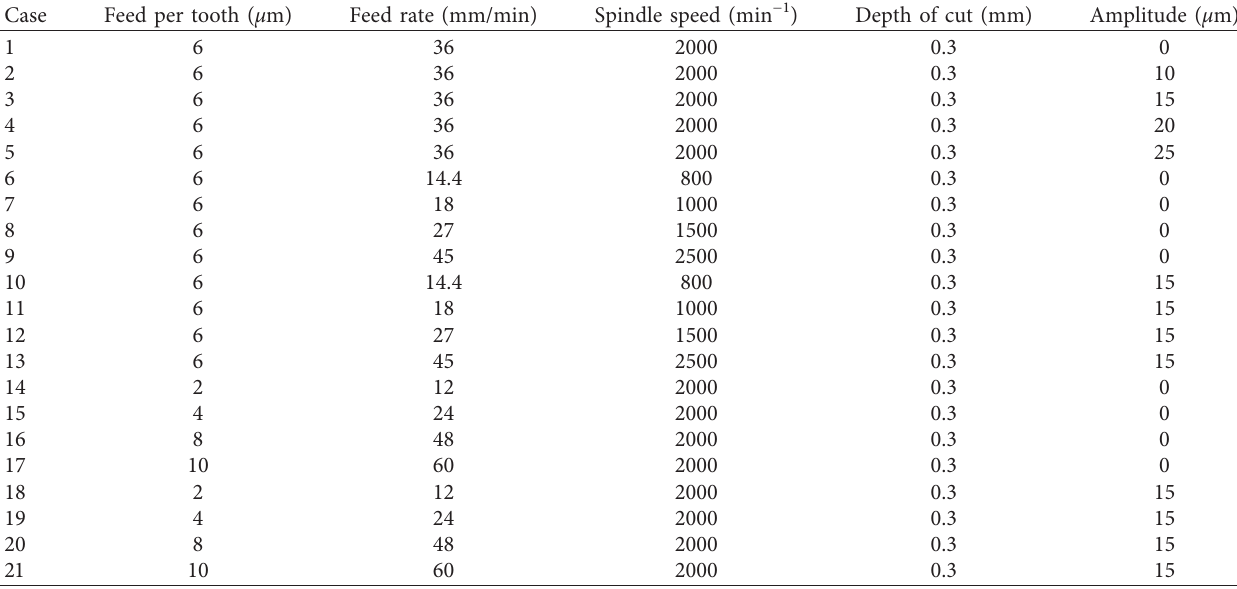
Table 5: Single-factor experimental set.